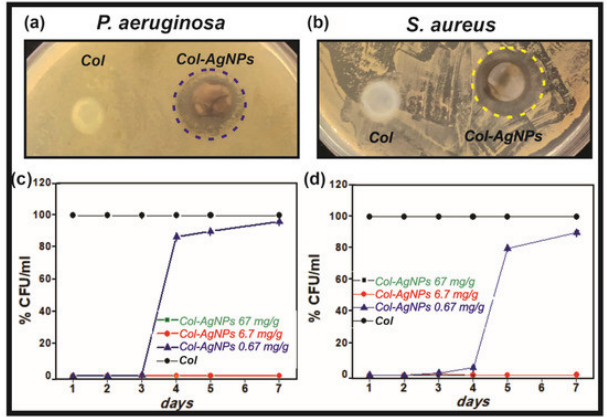
Figure 1. The antimicrobial activity of hydrogels against the P. aeruginosa ( a , c ) and S. aureus ( b , d ) bacteria (green and red lines match).